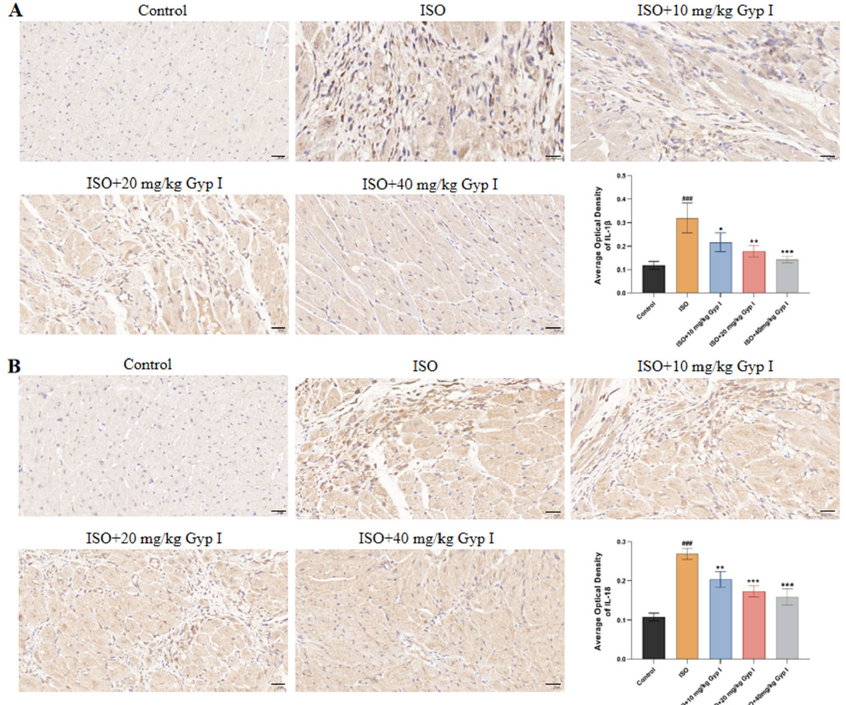
Figure 10. Immunohistochemical images of heart sections: ( A ) IL ‐ 1 β . ( B ) IL ‐ 18 (Scale bar: 20 μ m, n = 3, mean ± SD, ###: p < 0.001 compared with Control group; * p < 0.05, **: p < 0.01, ***: p < 0.001 compared with ISO group).